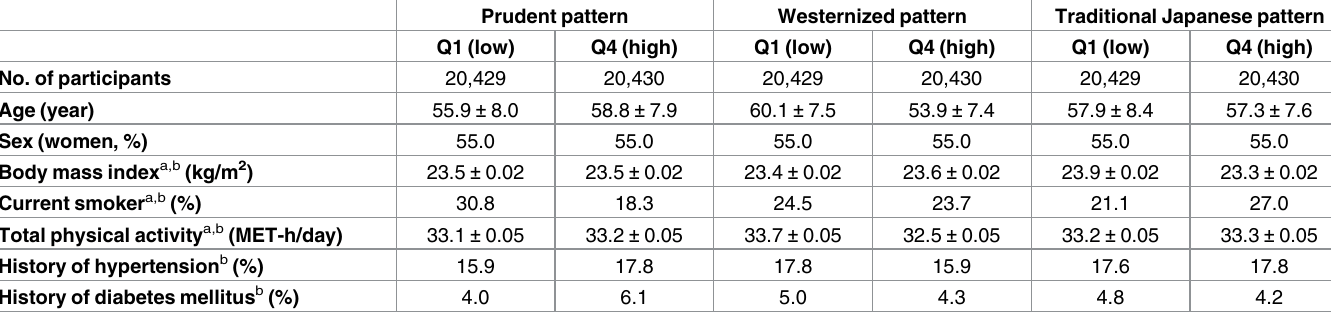
Table 1. Characteristics according to quartile (Q) of dietary pattern scores. Prudent pattern Westernized